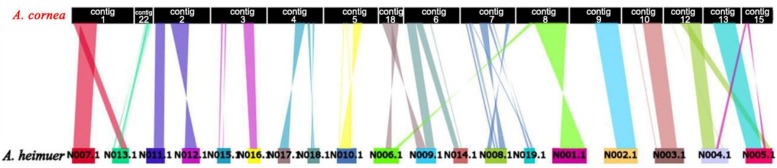
Whole-genome collinearity analysis of A. cornea and A. heimuer.